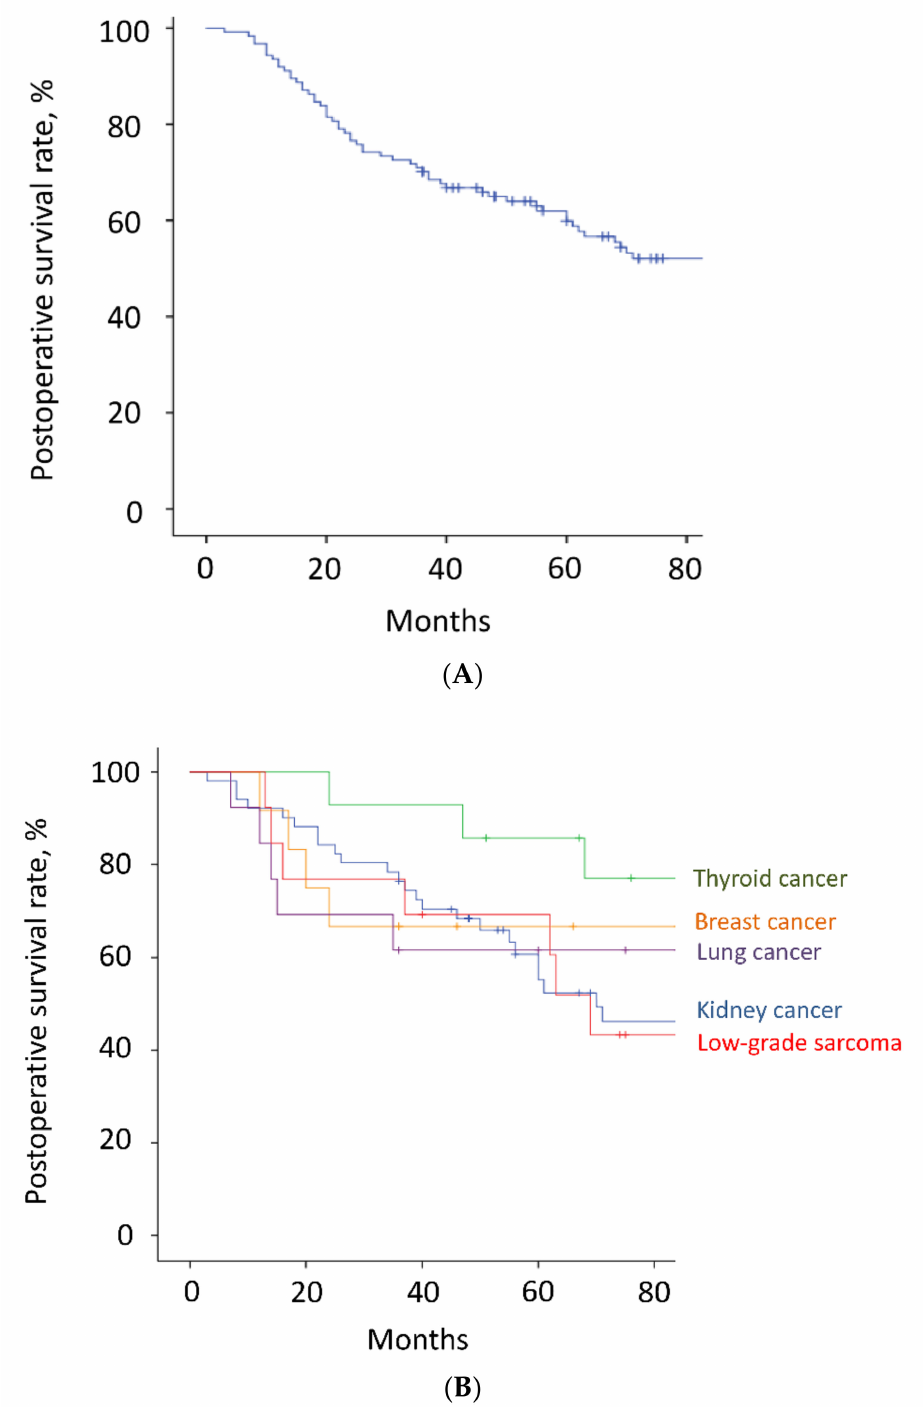
Figure 3. ( A ). Postoperative survival. Of all 124 patients, 36 patients died <3 years after surgery, whereas the other 88 patients survived ≥ 3 years after surgery. The 3-year and 5-year survival rates were 70% and 60%, respectively. The estimated median survival time was 93 months. The tick marks indicate the last date of follow-up. ( B ). Postoperative survival. The 3-year and 5-year survival rates of the patients with kidney cancer, thyroid cancer, low-grade sarcoma, lung cancer, and breast cancer were 77% and 61%, 93% and 86%, 77% and 69%, 62% and 62%, and 67% and 67%, respectively. The tick marks indicate the last date of